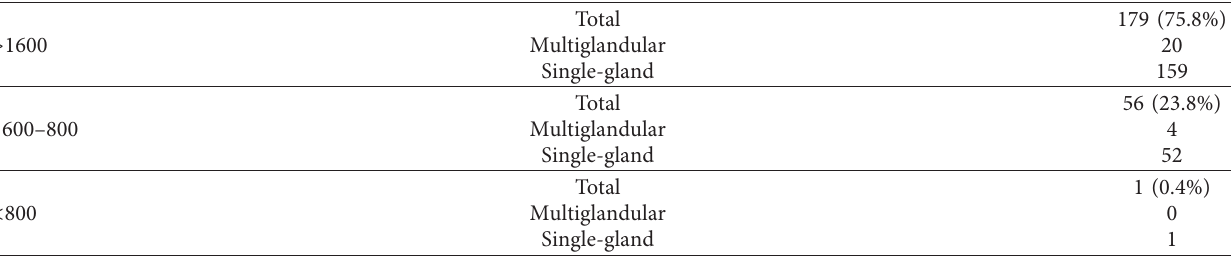
Table 10: Win index (Ca ∗ PTH).